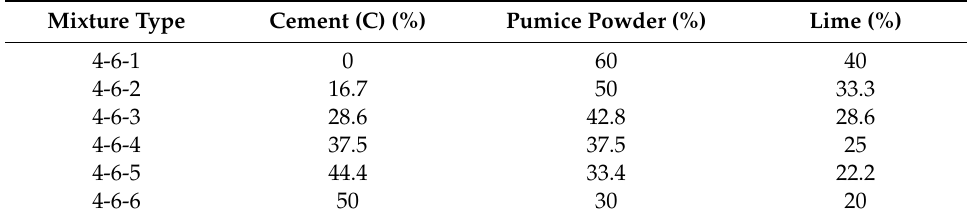
Table 12. Type 4-6 mixing